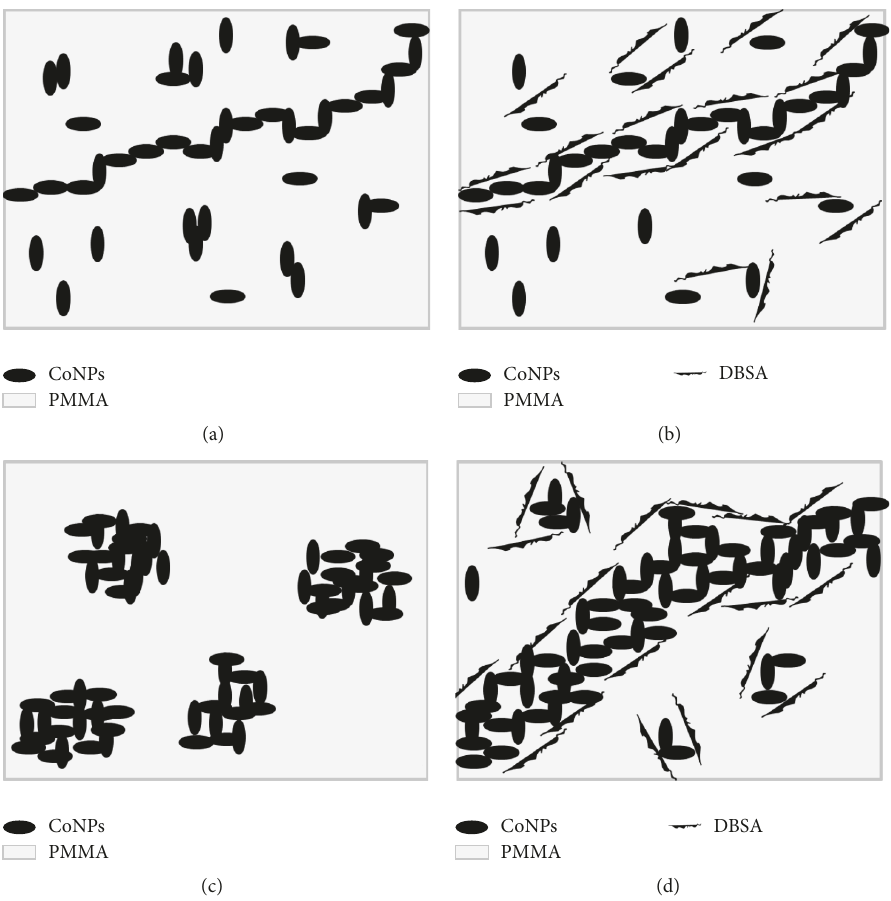
Figure 5: Graphical presentation of pattern of dispersion of fillers at percolation for CoNPs/PMMA (a) and DBSA-CoNPs/PMMA (b) and at filler contents higher than percolation threshold for CoNPS/PMMA (c) and DBSA-CoNPs/PMMA